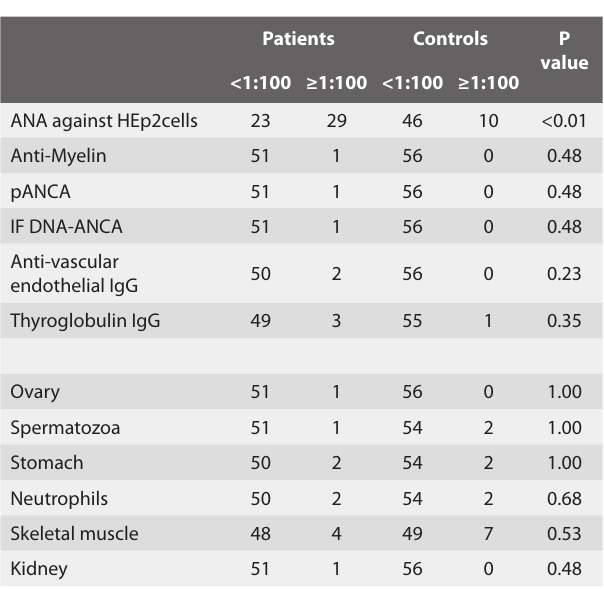
Table 2. Distribution of auto antibodies in patients versus controls.